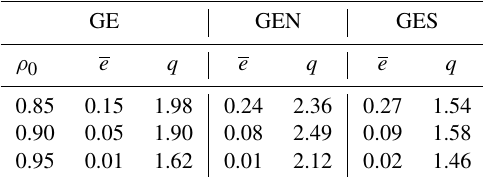
Table 4. Dependence of the average edge density e and the ratio q = e extr /e norm (edge density during extreme years to edge den- sity during normal years) over the period 1951–2019 on the corre- lation threshold ( ρ 0 = 0 . 85, 0.90 and 0.95). Results are shown for droughts during the SHY in the GE, GEN and GES